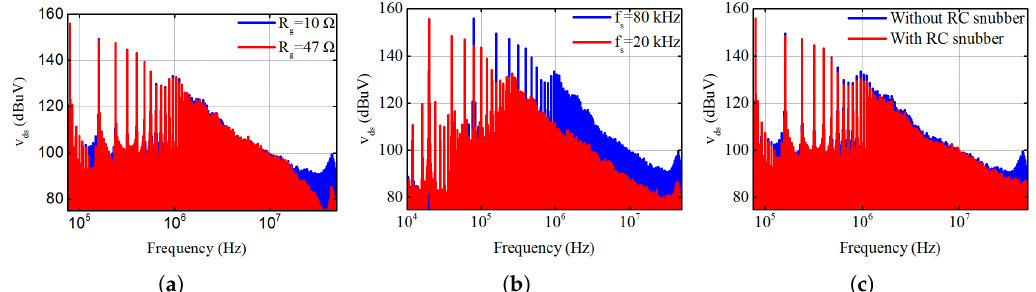
Figure 26. Spectra of the drain-source voltage of the SiC MOSFET: ( a ) R g ( ex ) = 10 and 47 Ω , ( b ) f s = 80 and 20 kHz, ( c ) with and without RC